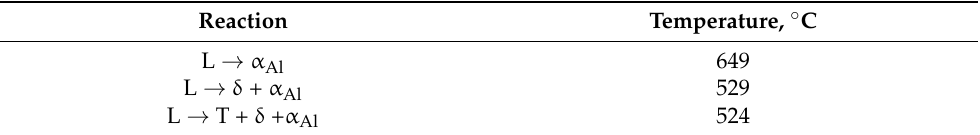
Figure 3. The non-equilibrium solidification sequence of Al-2.18Mg-1.92Li alloy based on the classic Scheil – Gulliver model: ( a ) the curve covering complete solidification and ( b ) the segment of the curve emphasizing the phase solidification. Table 3. The invariant reactions and corresponding temperatures for the Al-2.18Mg-1.92Li alloy’s non-equilibrium solidification sequence.